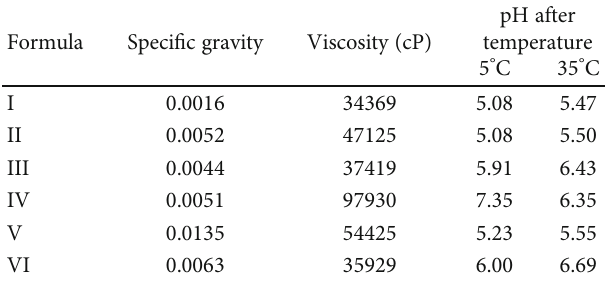
Table 4: Physicochemical properties of air freshener gel formulations. Formula